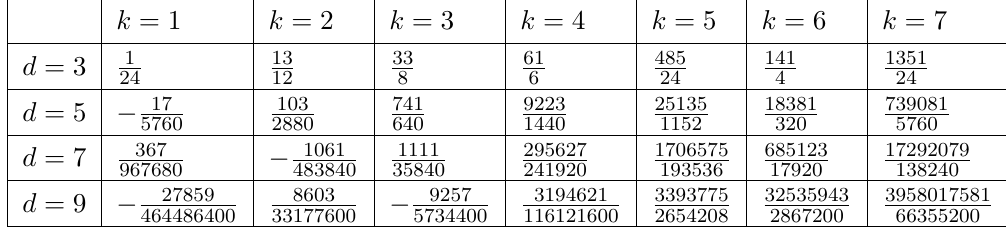
(cid:12) for scalars with 4 GJMS kinetic operator on HS d for various odd d and k . Table 1 . ∆ F ( ND ) (cid:12) 2 k log The integrand has zeros at half integer values of k which in turn means f ND ( d, k ) has local maxima and minima at these values.